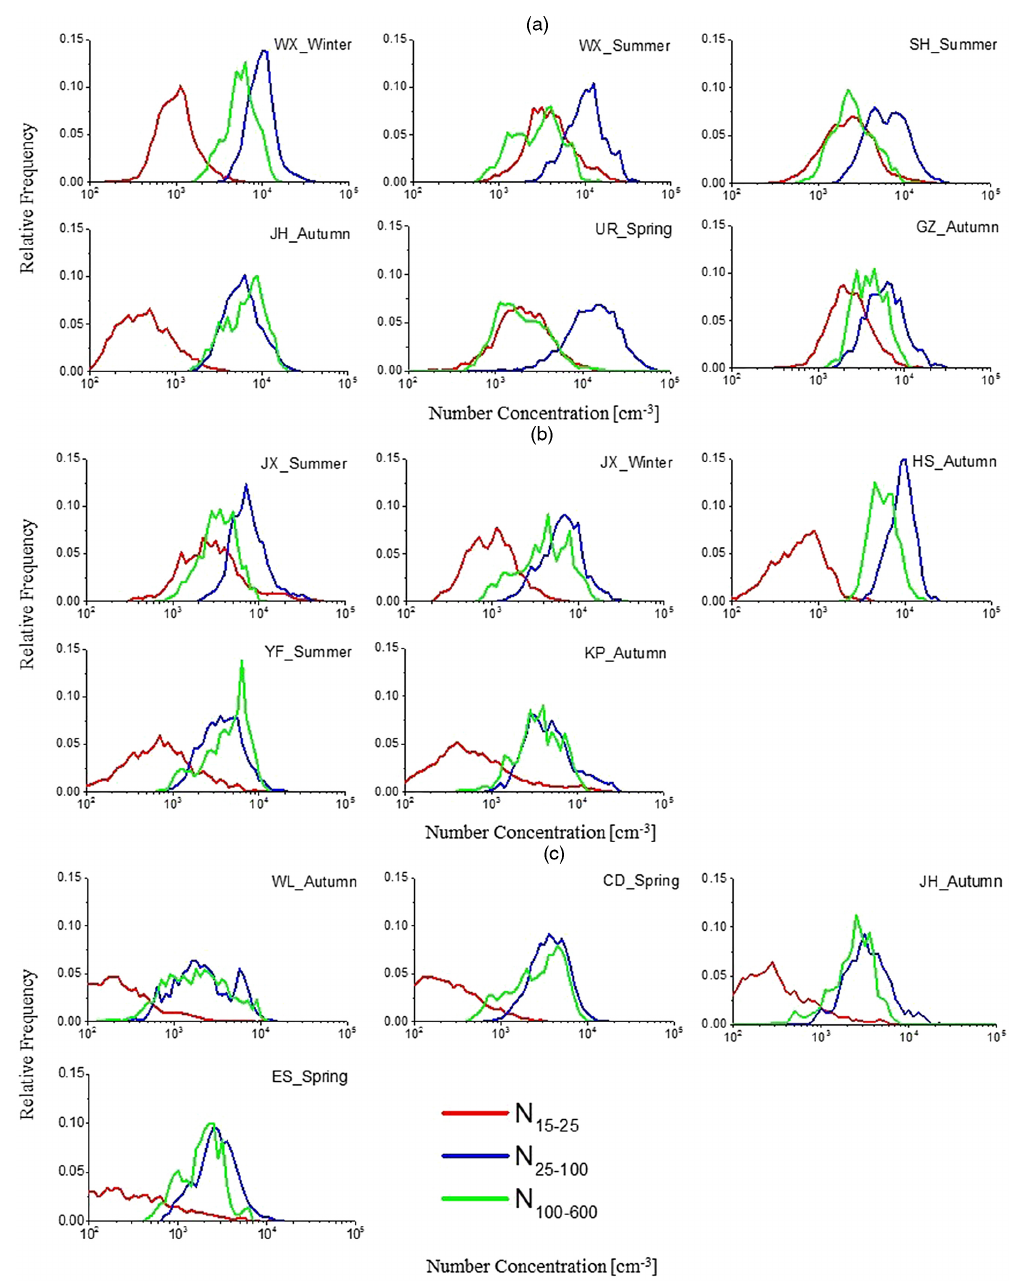
Figure 3. Distribution of PNC in different size ranges at (a) urban sites, (b) regional sites, (c) coastal sites and ship measurement. The red, blue and green line represents the distribution of N 15 − 25 , N 25 − 100 and N 100 − 600 ,